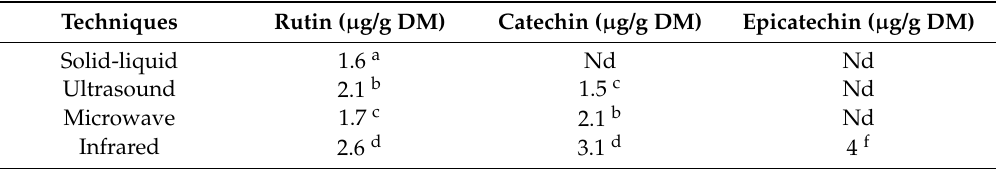
Table 2. Polyphenols’ composition by High Performance Liquid Chromatography obtained with different extraction techniques. Different superscript letters indicate a significant statistical difference ( p < 0.05). Nd: